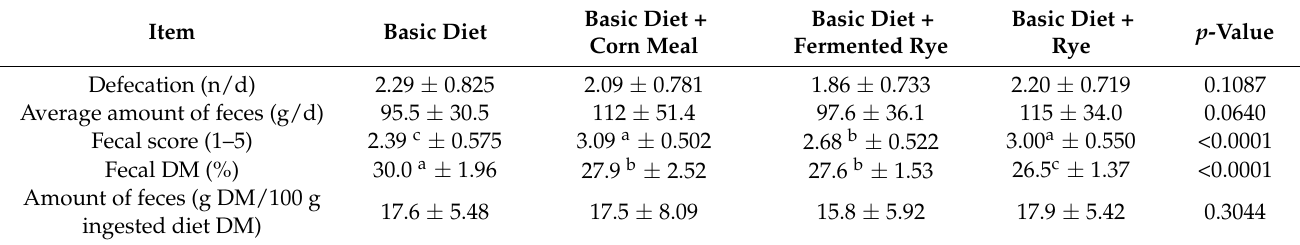
Table 5. Number of defecations, average daily amount of feces, fecal score, and amount of feces g DM/100 g ingested diet DM of dogs fed the vegetarian diet (basic) and the experimental diets supplemented with hydrolyzed feather meal as well as either corn meal, fermented rye or rye (mean ± SD).